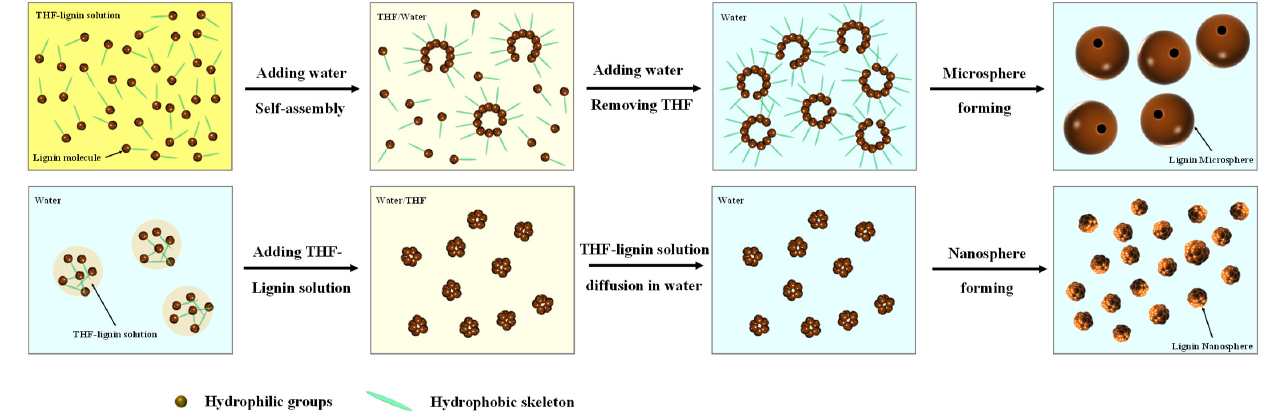
Figure 6. Lignin condensation facilitates solution-based self-assembly for the production of spherical lignin nanoparticles.